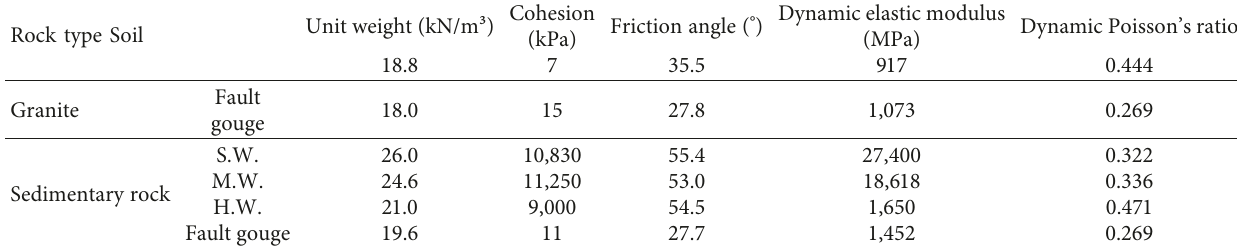
Table 2: Applied physical and mechanical properties for the time-history analysis of each rock type. The slope consists of soil and fault gouge that originated from granite and sedimentary rock, and slightly weathered (S.W.), moderately weathered (M.W.), and highly weathered (H.W.) sedimentary rocks.